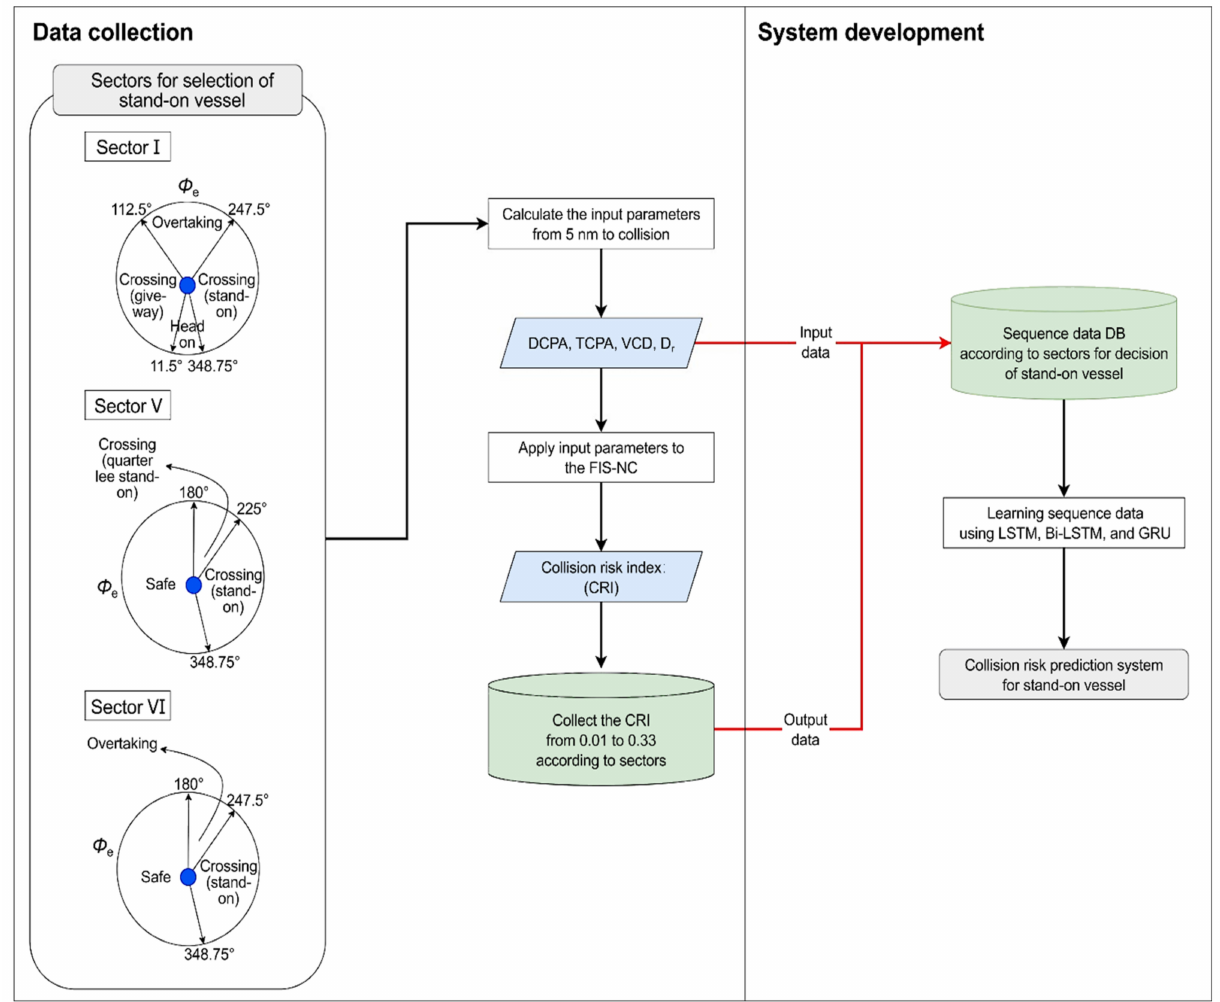
Figure 8. Development process of collision risk prediction system for stand-on